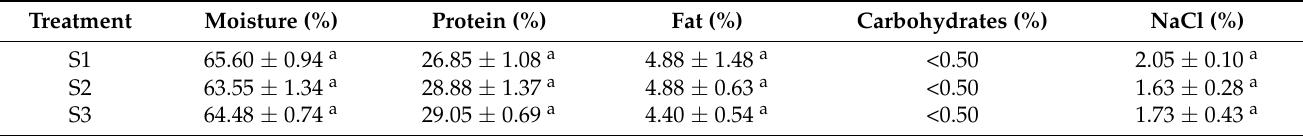
Table 1. Chemical composition and chloride content in the examined pork